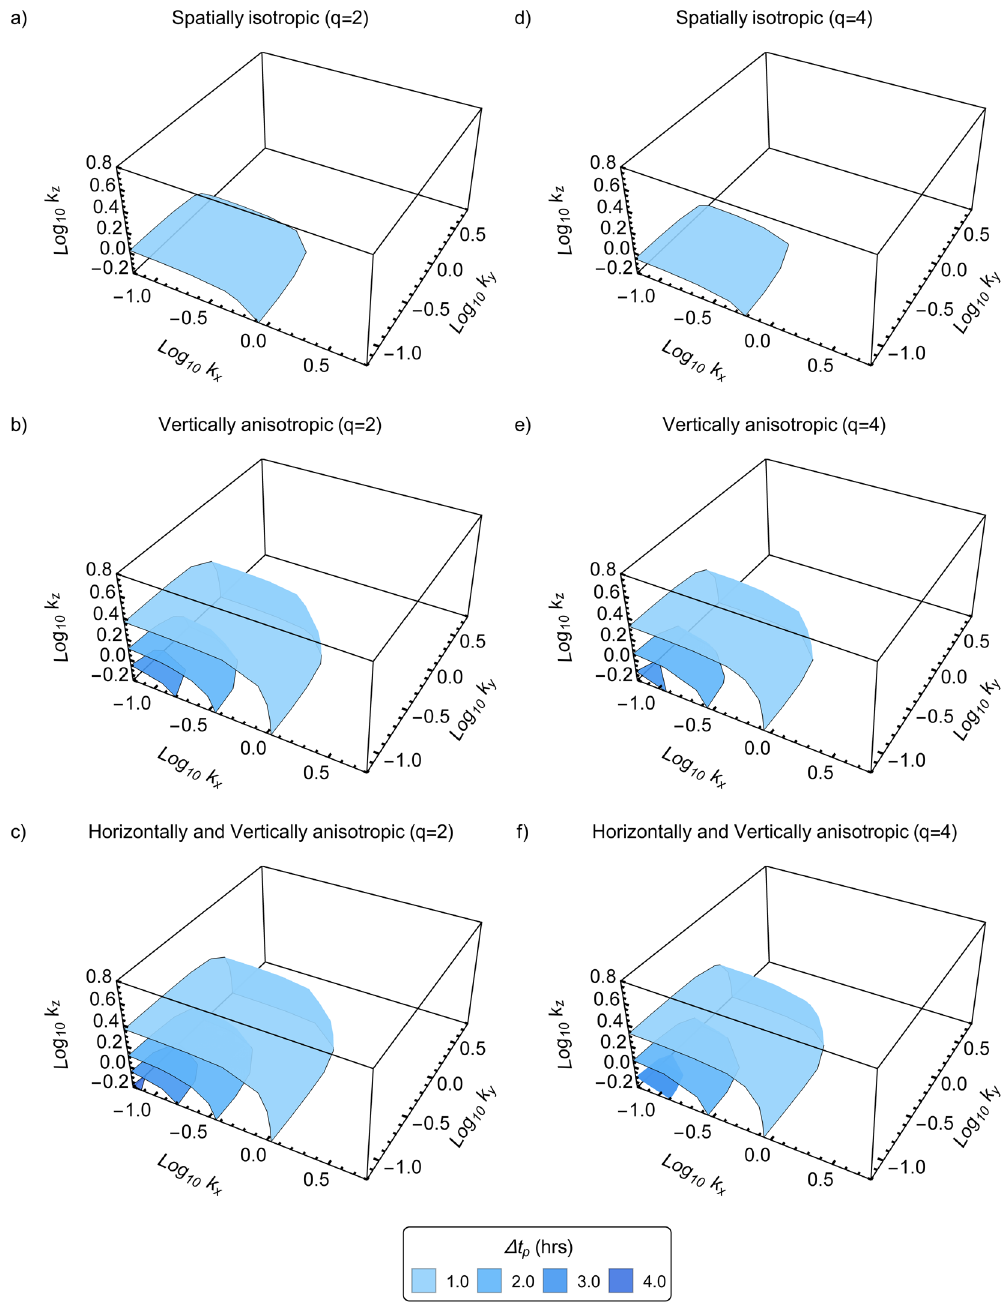
Figure 2. Theoretical predictability limits of spatially isotropic and anisotropic (with 1000 m sphero-scale) horizontal wind fields. The wind fields have multifractal parameters α = . = . = . C H 1 5, 0 15, 0 33, and 1 anisotropy parameters as discussed in the text. The wavenumbers k x , k y , k z have units of km − 1 and are in the x , y , z directions respectively, whereas the predictability limits are in hours. The horizontal wavenumbers represent a scale range from 1 to 100 km, whereas the vertical wavenumber represents a scale range from 1 to 10 km (scales smaller than 1 km are not shown here as their predictability limits are less than 1 hour). The two rows differ only by the order of autocorrelation q used in deriving the predictability limits. ( a ) spectra based predictability limits ( q = 2) of an isotropic horizontal wind field as a function of logarithmic wavenumber. ( b ) same as a, but for vertically anisotropic cases. ( c ) same as a, but for horizontally and vertically anisotropic cases. ( d–f ) are same as a, b, c but for q = 4. Comparing figures ( a–c ) with ( d–f ) shows that higher-order predictability limits are smaller than lower-order ones. Since higher-order statistical moments represent more extreme events, these figures indicate that such events are less predictable. Comparing figures ( a–c ) with each other and figures ( d–f ) with each other illustrates that fields that are more anisotropic are more predictable. Comparing Fig. 1 with this figure shows that fields with larger sphero-scales are less